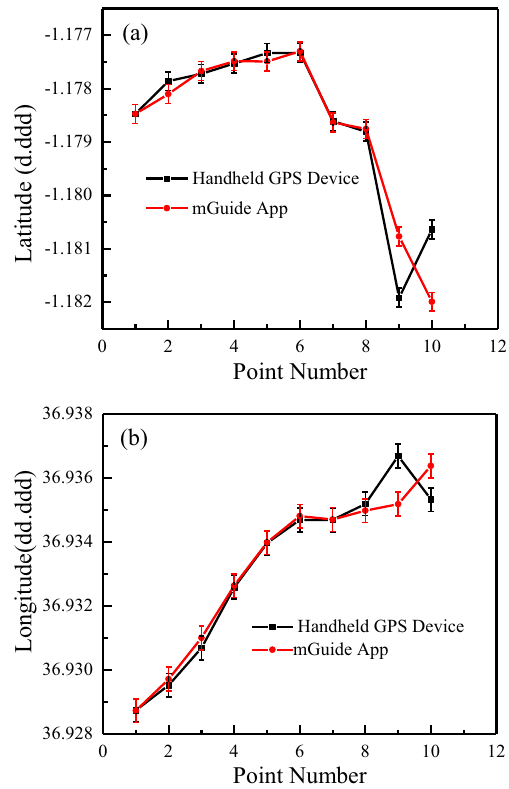
Fig. 7 Graph of latitude against point number for Art zone 39 route. a Latitudes and b longitudes variations